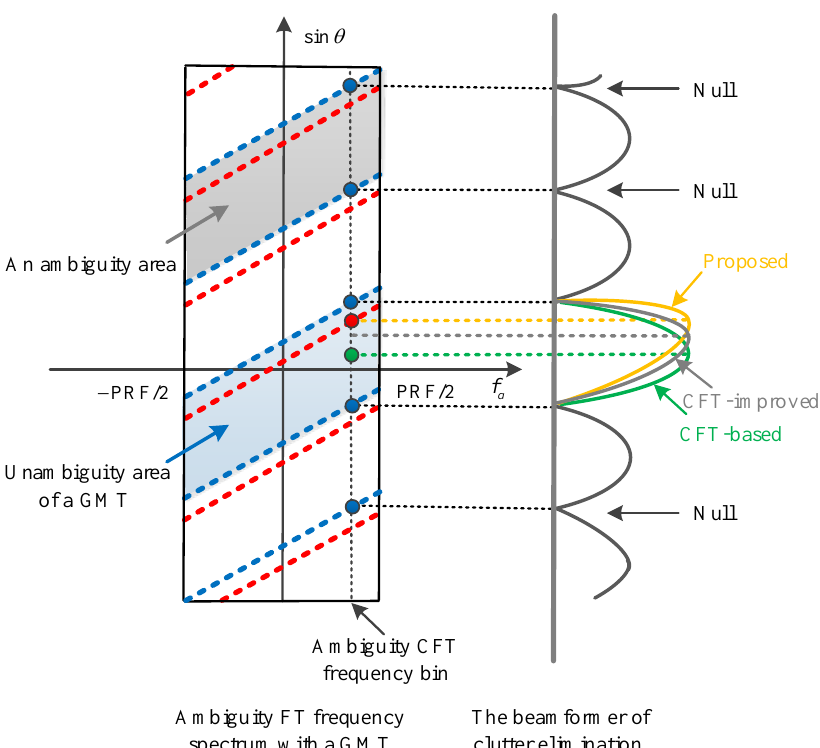
Figure 4. The beamformer of clutter suppression for different